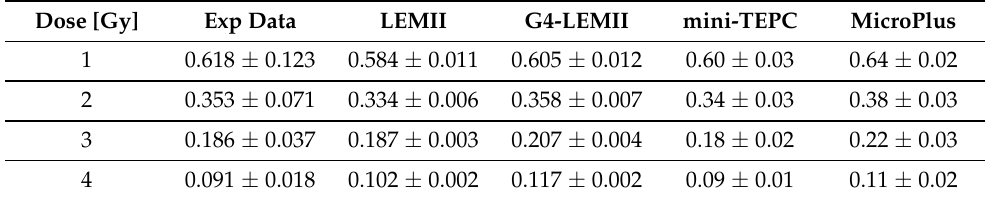
Table 4. Survival Fraction of the ARPE19 cell line obtained applying the three approaches: LEMII, Geant4 coupled with LEMII and Loncol’s function applied to the microdosimetric spectra. The first column reports experimental data.